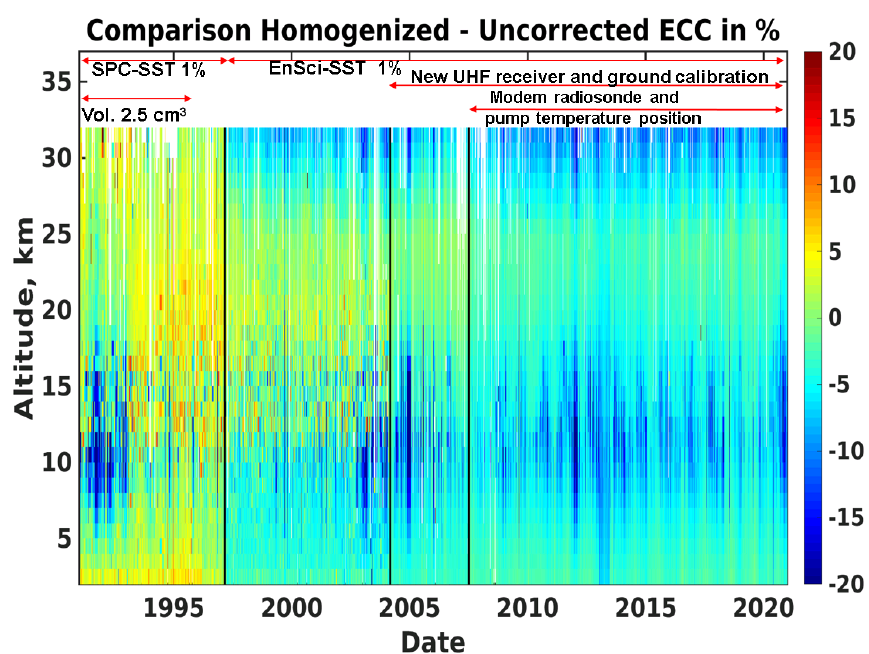
Figure 2. Time evolution of the relative difference between homogenized and uncorrected ozone concentrations as a function of altitude. Color scale is in percent (%). Major changes in the sounding procedure or processing are shown in the top part of the figure. Pump flow rate corrections and removal of I b pressure dependency are applied to the entire dataset.